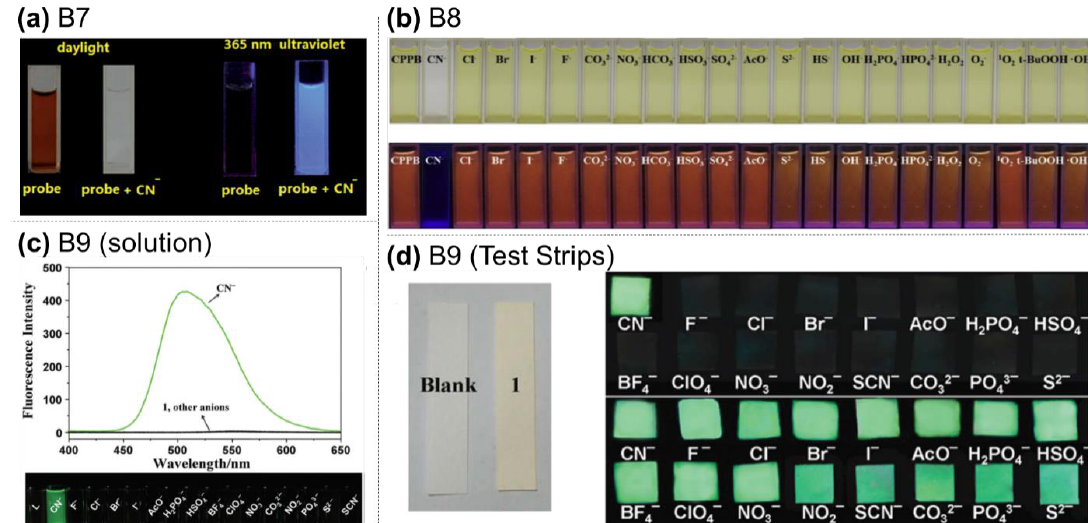
Figure 7. ( a ) Photos showing colour and fluorescence change of B7 in water before and after addition of cyanide. Reproduced with permission from [80]. Copyright 2016, the Royal Society of Chemistry. ( b ) Photos showing the selective decolourisation and emission-quenching of B8 in aqueous solution by cyanide. Reproduced with permission from [81]. Copyright 2019, Elsevier B. V. ( c ) Photoluminescence spectra and photos of B9 in the presence of different anions. ( d ) Photos showing the colour of B9 -coated test papers, and its emission test papers after exposure to various anions in